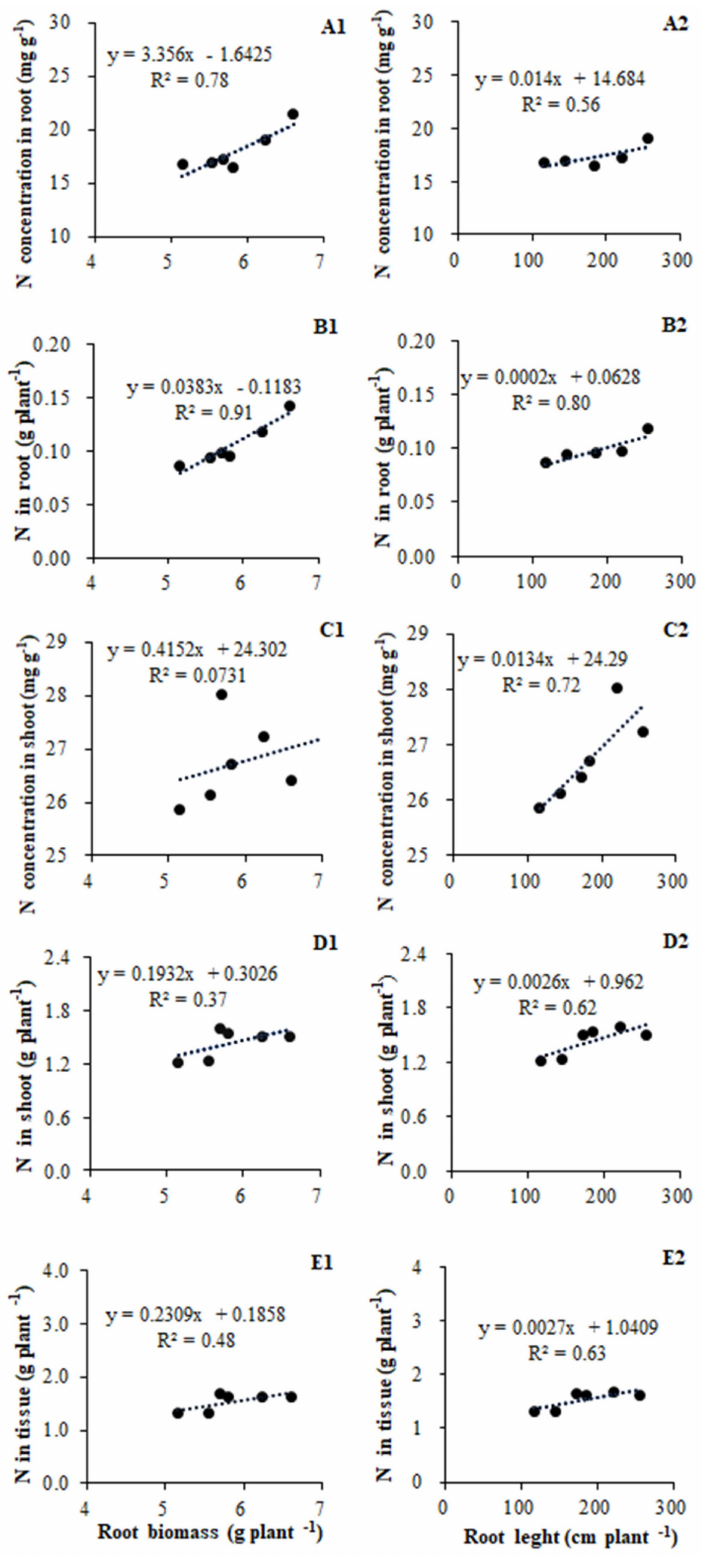
Figure 4. Relationships between root growth and N acquisition in tomato according to data of root biomass, length, and genes repress of inoculated treatments ( A1 , A2 , B1 , B2 , C1 , C2 , D1 , D2 , E1 , E2